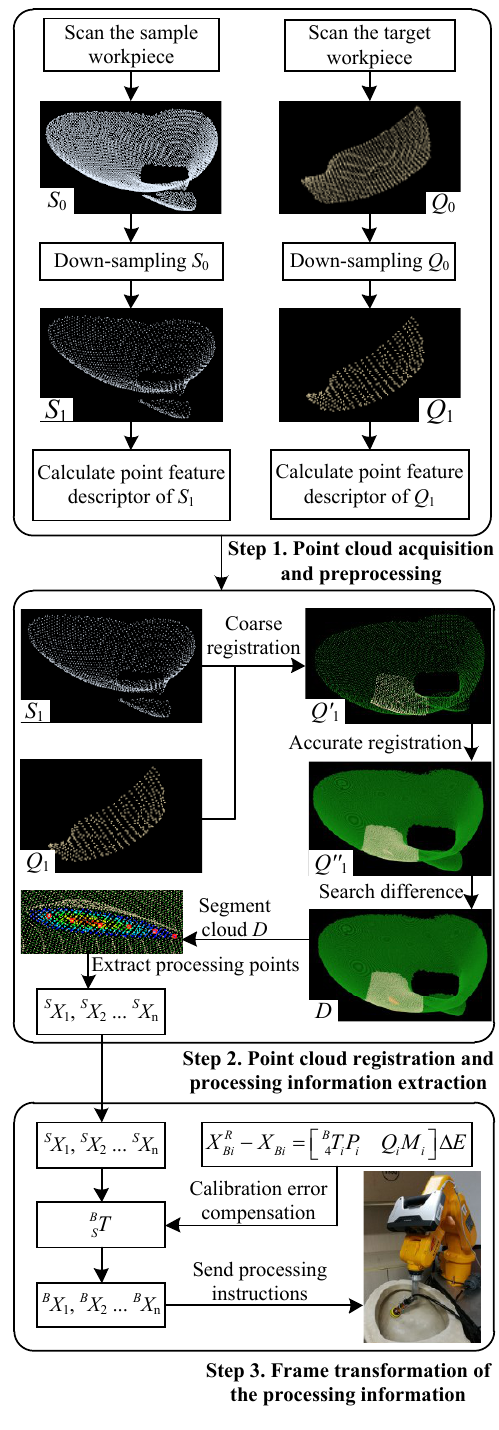
Figure 2. Procedure of data processing of the grinding robot 3D vision